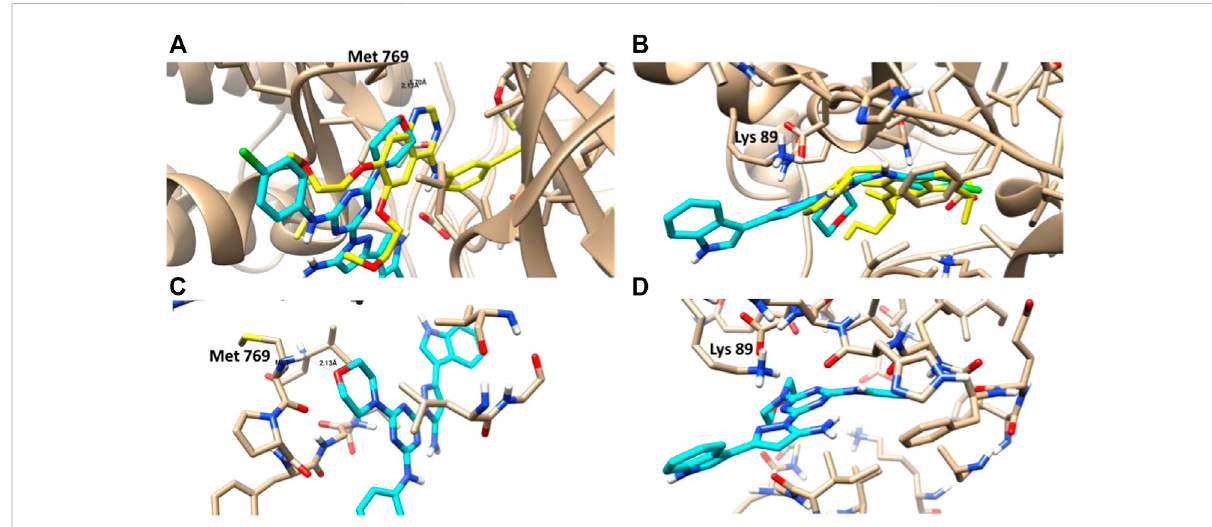
FIGURE 6 (A,B) : Molecular representation of the docked compound 3i (Cyan) with the co-crystallized ligand (yellow) towards the EGFR and CDK-2 proteins. (C,D) : Interactive binding mode of the docked compound 3i with the key amino acids; Met 769 for EGFR and Lys 89 for CDK-2.